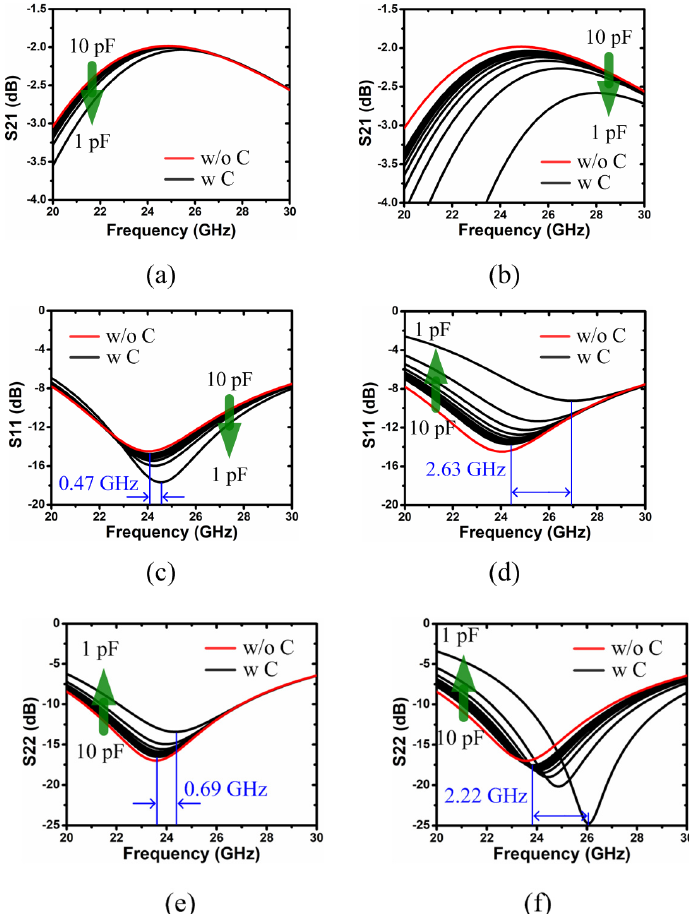
Figure 4. ( a ) Simulated S21 of the topology with series-connected DC-blocking capacitor, ( b ) simulated S21 of the topology with parallel-connected DC-blocking capacitor, ( c ) simulated S11 of the topology with series-connected DC-blocking capacitor, ( d ) simulated S11 of the topology with parallel-connected DC-blocking capacitor, ( e ) simulated S22 of the topology with series-connected DC-blocking capacitor, ( f ) simulated S22 of the topology with parallel-connected DC-blocking capacitor.